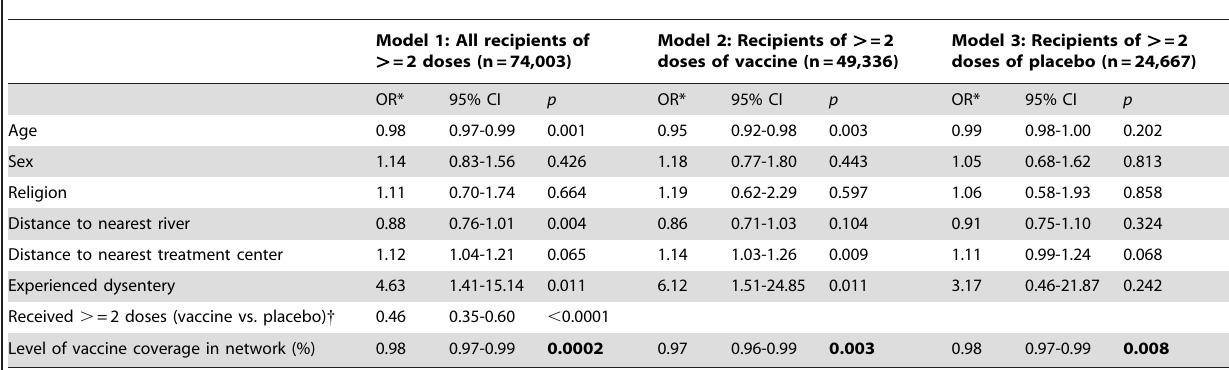
Table 2. Predictors of cholera risk in recipients of vaccine or placebo, bari -level social networks.